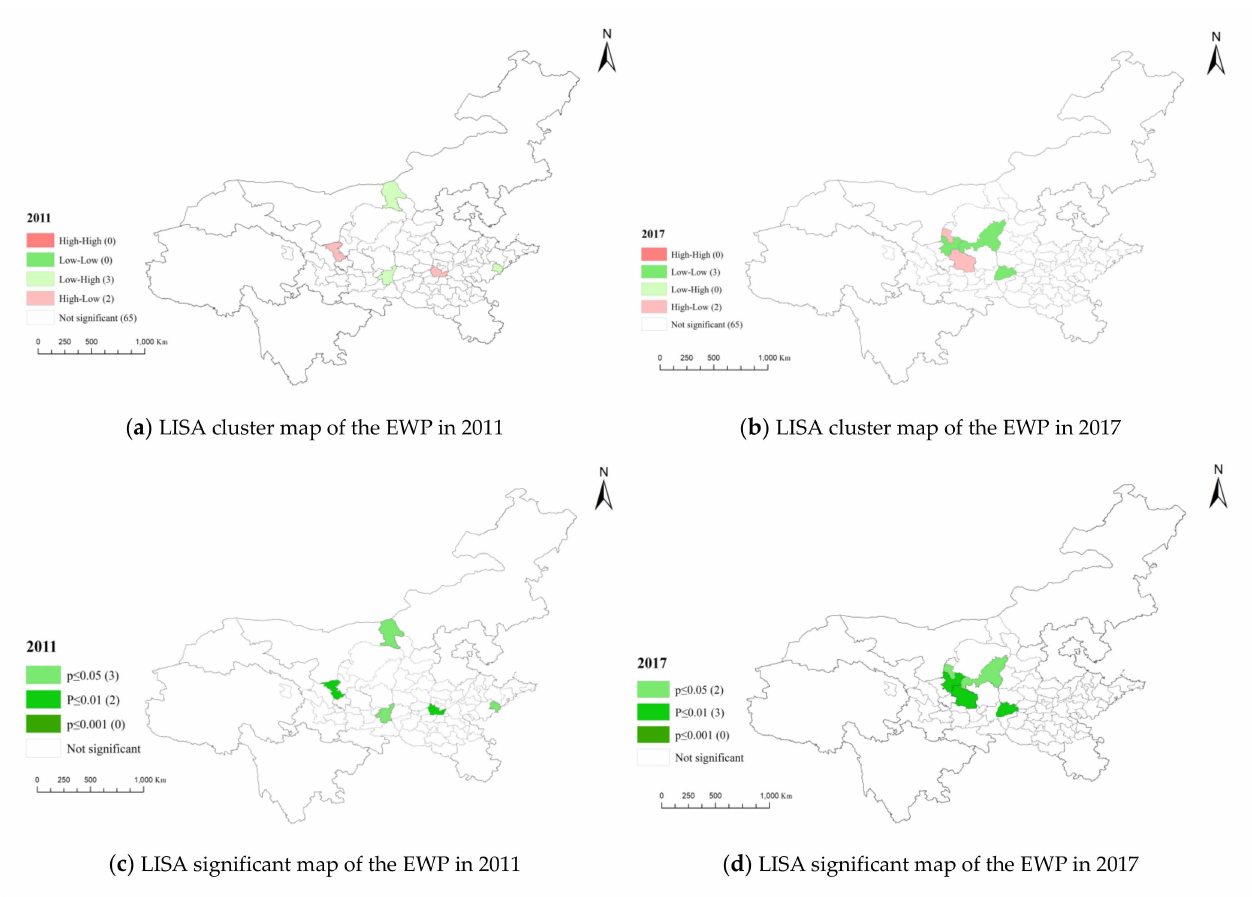
Figure 8. LISA cluster map and LISA significant map of the EWP in 2011 and 2017. It can be found that in 2011, Zhongwei and Xinxiang were situated in the H-L quadrant, and the significance of the two cities was at the 1% level, while Baotou, Weinan, and